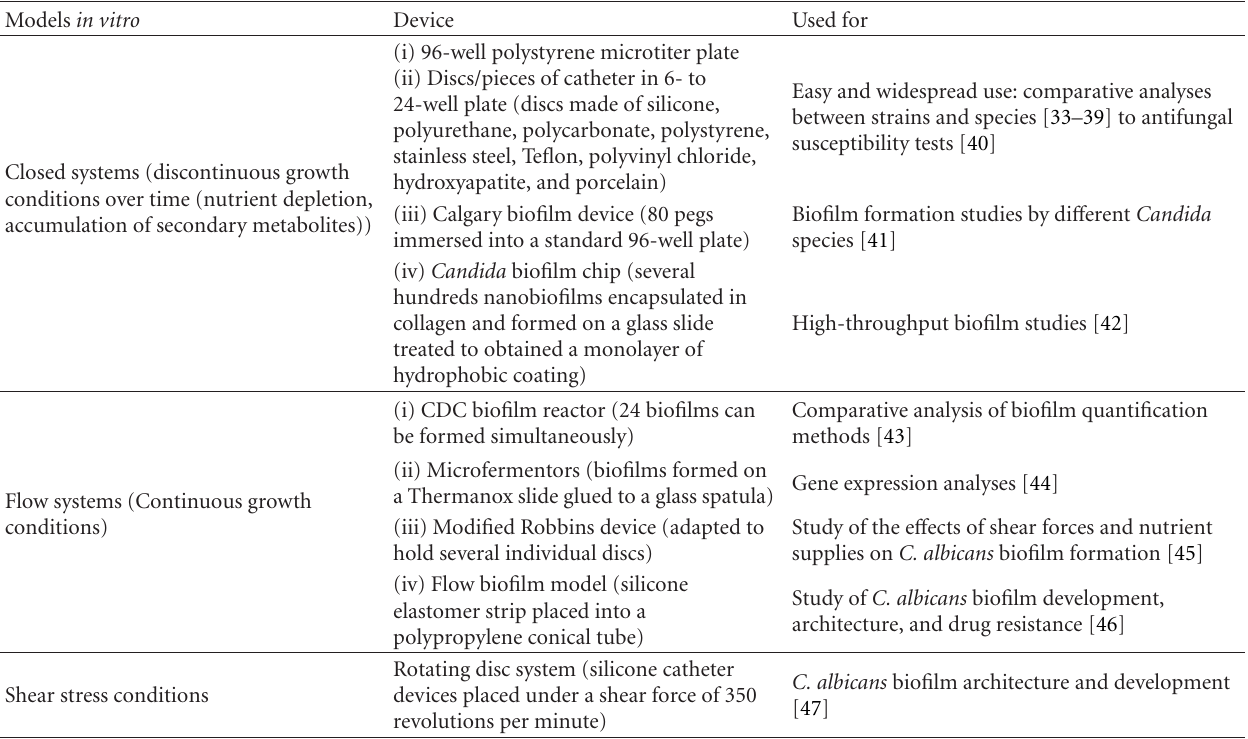
Table 1: Examples of Candida biofilm models in vitro .